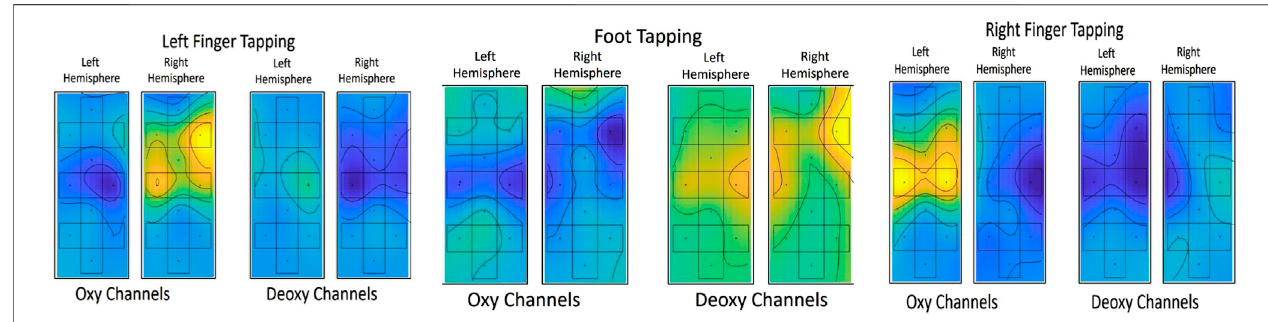
FIGURE 4 | Brain Imaging Representation (Oxy and Deoxy channels) for the three tasks.